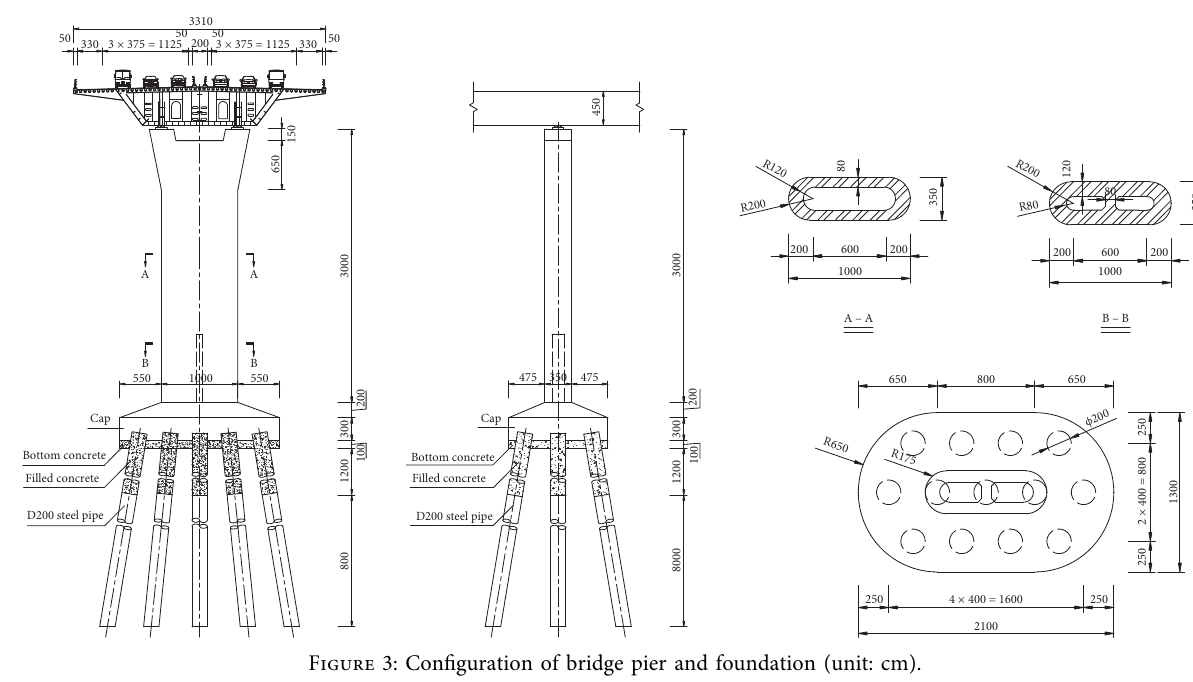
Figure 3: Configuration of bridge pier and foundation (unit: